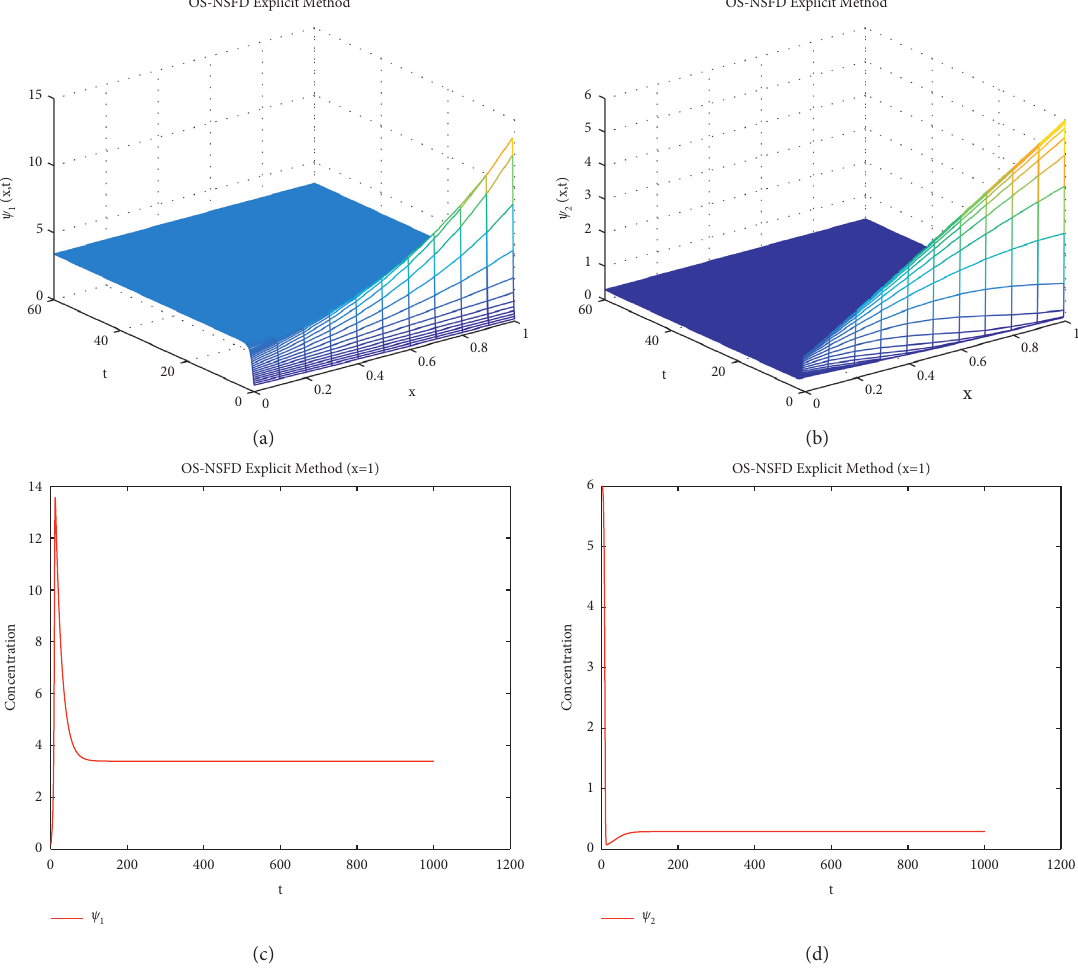
and ψ implementing NSFD explicit splitting method at 1 2 � ε � 10 − 4 . (a) Mesh graph of ψ . (b) Mesh graph of ψ ψ 1 ψ 1 1